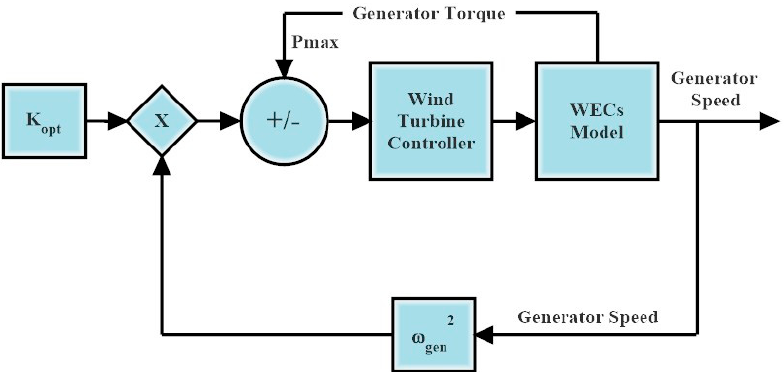
Figure 9. OT control